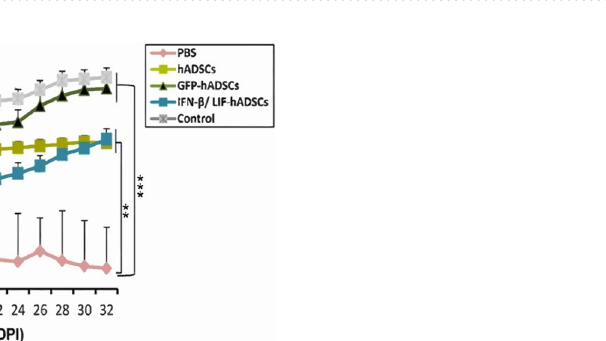
Figure 3. hADSCs overexpressing IFN-β and LIF reduced the severity of EAE disease in immunized mice. Clinical scores were monitored daily in all five groups for up to 32 days after immunization. Generally, there were significant differences in the mean clinical scores among the three treatment groups and the PBS group [H(3) = 110.456, p = 0.000]. Results were shown as mean ± SEM. * P < 0.05, ** P < 0.01, *** P < 0.001. Nonparametric Kruskal–Wallis tests were used to compare the clinical scores among the groups.